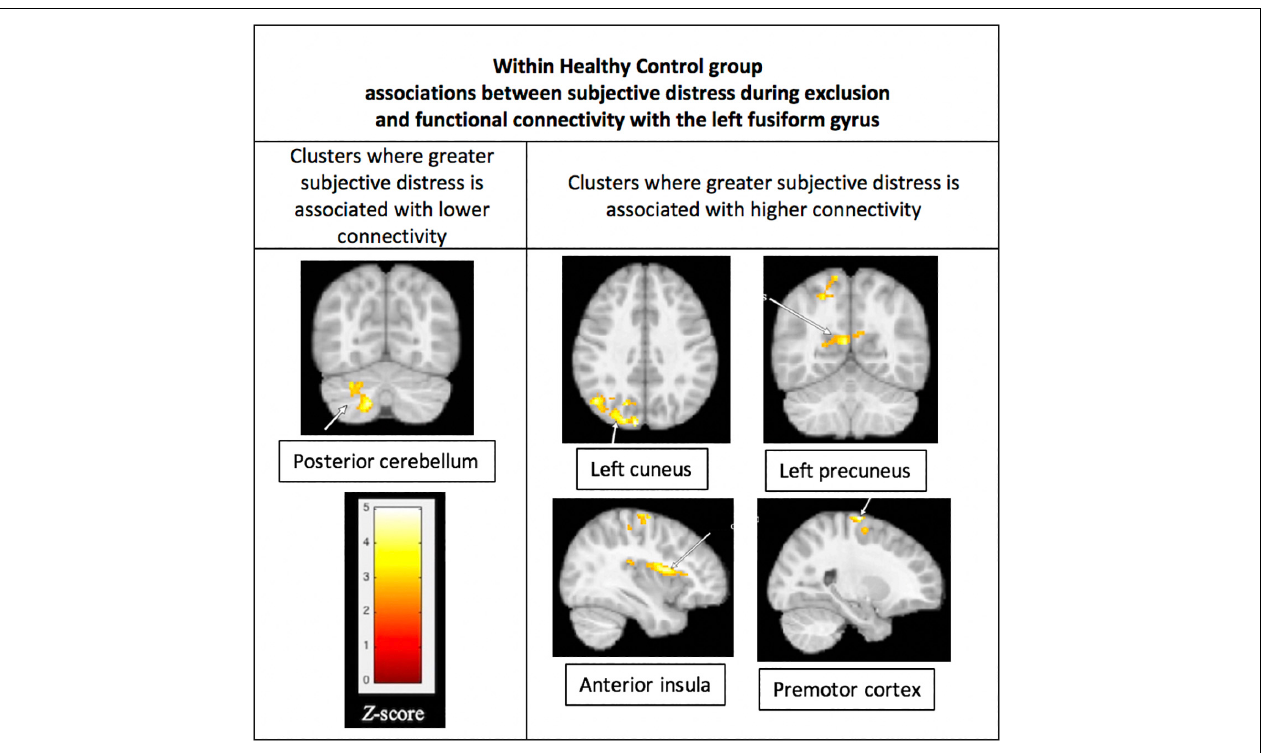
FIGURE 5 | Associations between subjective distress and functional connectivity with the left fusiform gyrus (FFG). Within the HC group, greater distress during social exclusion was associated with lower connectivity between the fusiform gyrus and the left posterior cerebellum ( p = 0.004), shown in the (left) column of the figure. Also for the HC group, greater distress was associated with higher connectivity of the cuneus, precuneus, insula, and premotor cortex, as shown in the (right) column. Functional connectivity was performed using the left FFG cluster as the seed in a generalized PPI analysis, with a threshold of p < 0.05, FWE corrected at the cluster level. Results were not significant within the Bipolar Disorder